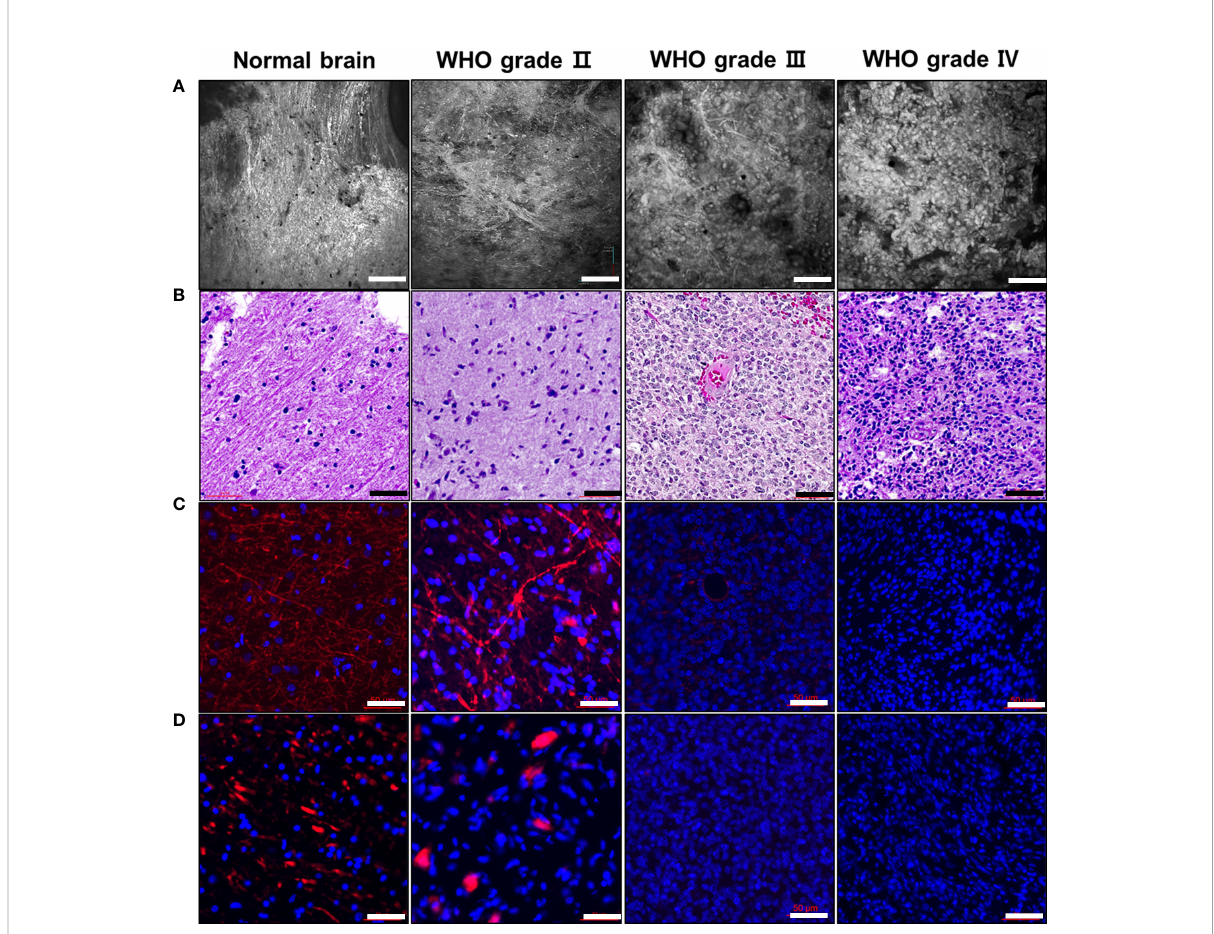
FIGURE 6 Representative photomicrographs of CLE images and glioma histology Compared to normal brain tissue, gliomas are classi fi ed as IDH1 -mutant gliomas (WHO grade II), anaplastic oligodendroglioma (WHO grade III), and glioblastoma (WHO grade IV). (A) CLE images of different glioma samples, according to their corresponding WHO grades, were obtained. Each glioma sample displayed a variety of morphological phenotypes, including cellularity and streak-like patterns. (B) H&E staining of the same tissue showing distinct histological differences in glioma grade, which was examined to identify cellularity, atypia, mitosis, and angiogenesis. (C, D) As a typical marker for axon fi bers, myelin basic protein (MBP) and neuro fi lament stains were examined at the corresponding glioma tissues. Similar to the CLE images, the amount of MBP and neuro fi lament staining were signi fi cantly decreased in high-grade gliomas. Scale bar: 50 µm. H&E, hematoxylin and eosin; WHO, World Health